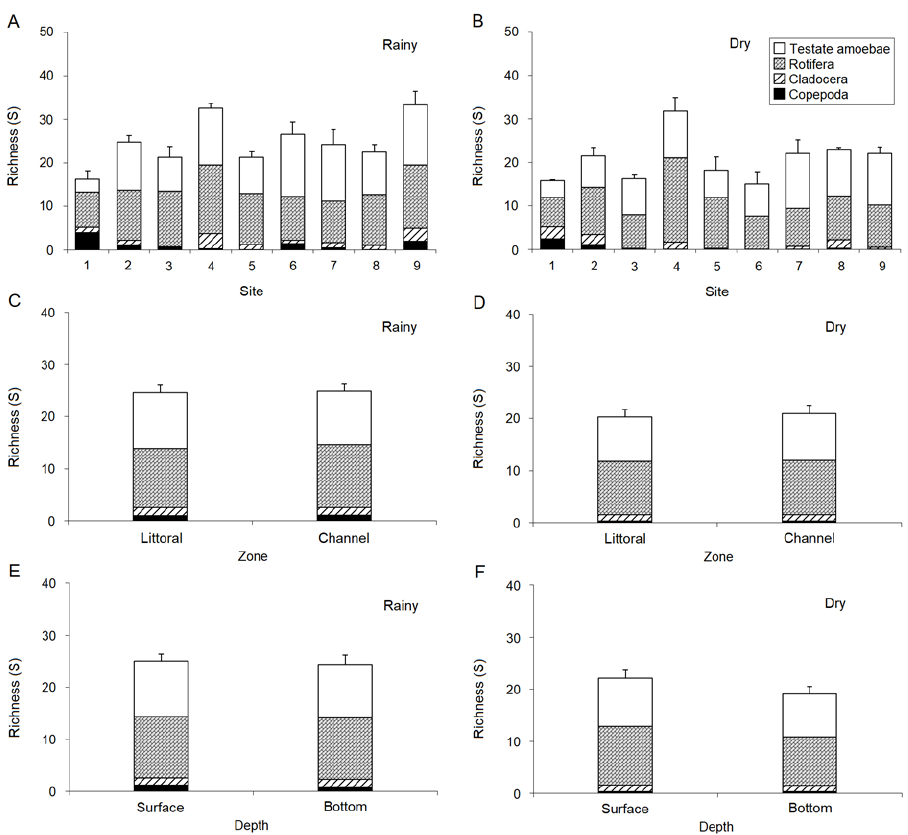
Figure 4. Zooplankton species richness of sites (A and B), zones (C and D), and depths (E and F) of the Aporé River, Paranaíba River basin, during the different hydrological seasons. Data were represented as mean ± standard error.